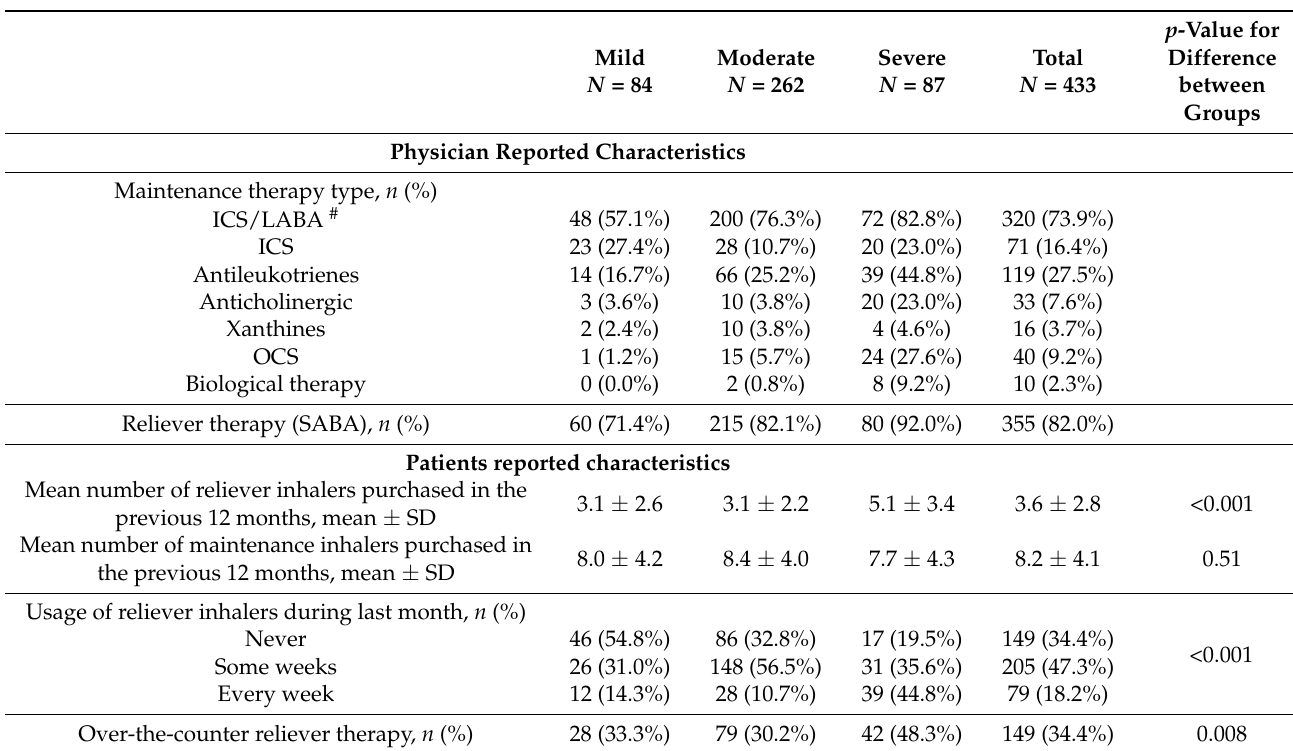
Table 3. Asthma therapy usage as reported by patients and